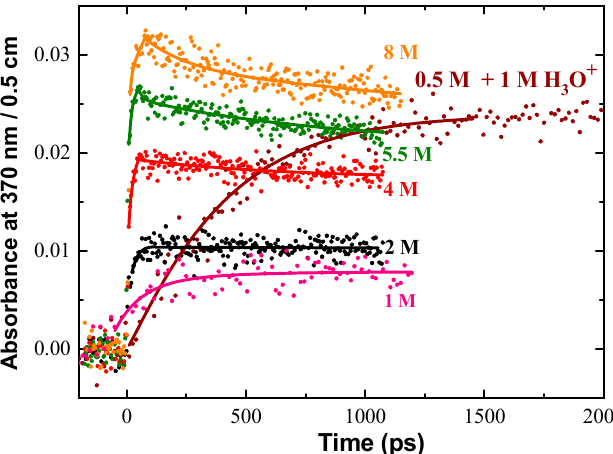
Figure 4. Transient kinetics observed at 370 nm in a wide range of NaCl aqueous solutions to show the products of oxidation of Cl − . The absorbance of hydrated electron and transient signal from irradiated fused silica were subtracted from the raw data. The solid lines are drawn to guide the eye. The absorbed dose (22.5 Gy per pulse) was the same for all kinetics. The acid used to adjust the pH of solution was HClO 4 . Adapted from [37].